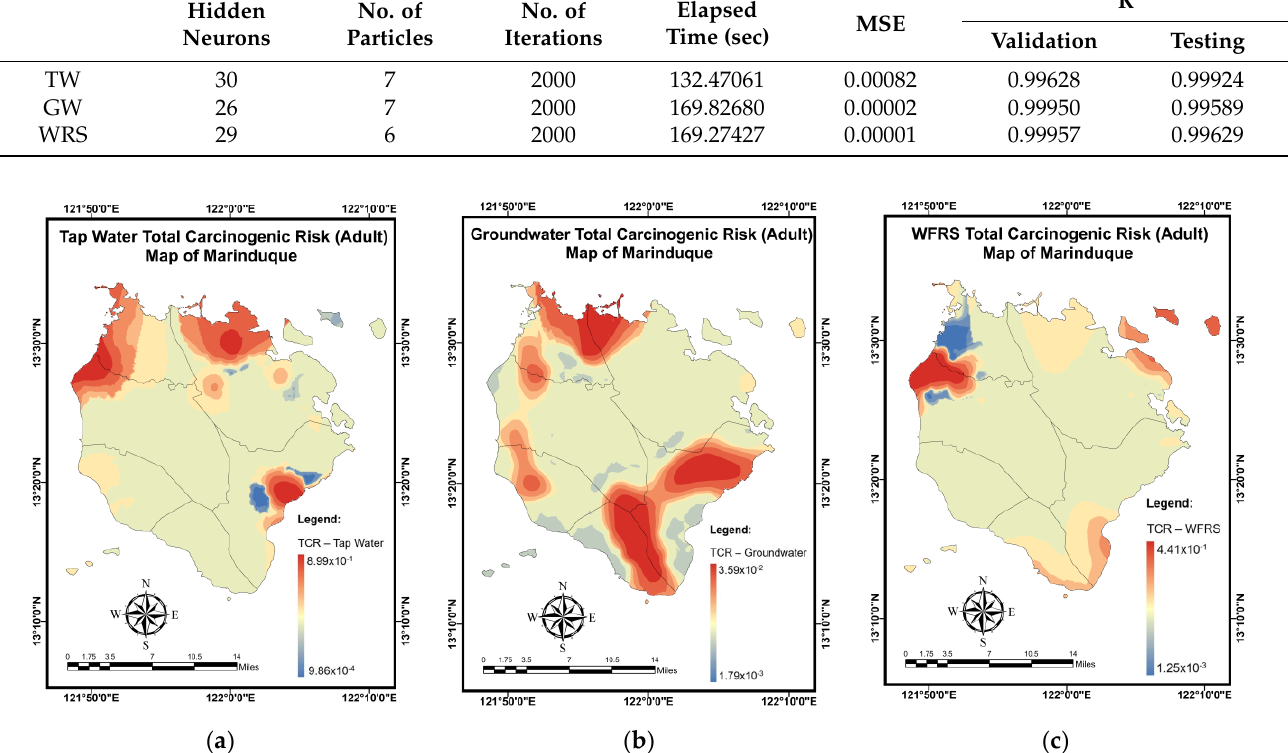
Figure 18. Spatial maps of TCR (adult) developed using MLGI approach for ( a ) TW samples, ( b ) GW samples, and ( c ) WRS samples.